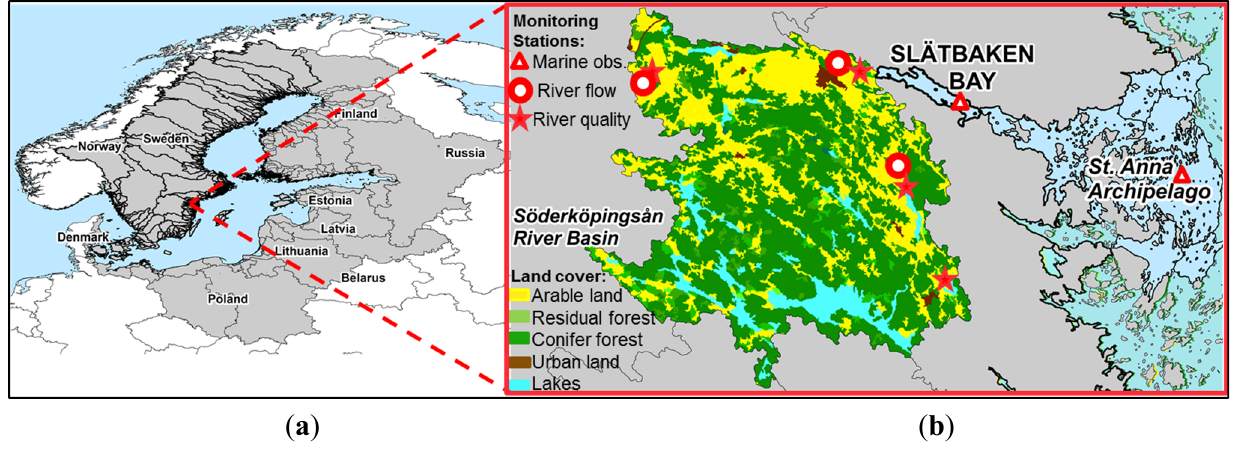
Figure 1. The Baltic Sea catchment area and the location of the semi-enclosed Slätbaken Bay ( a ), catchment and land cover of the major river, and monitoring sites ( b